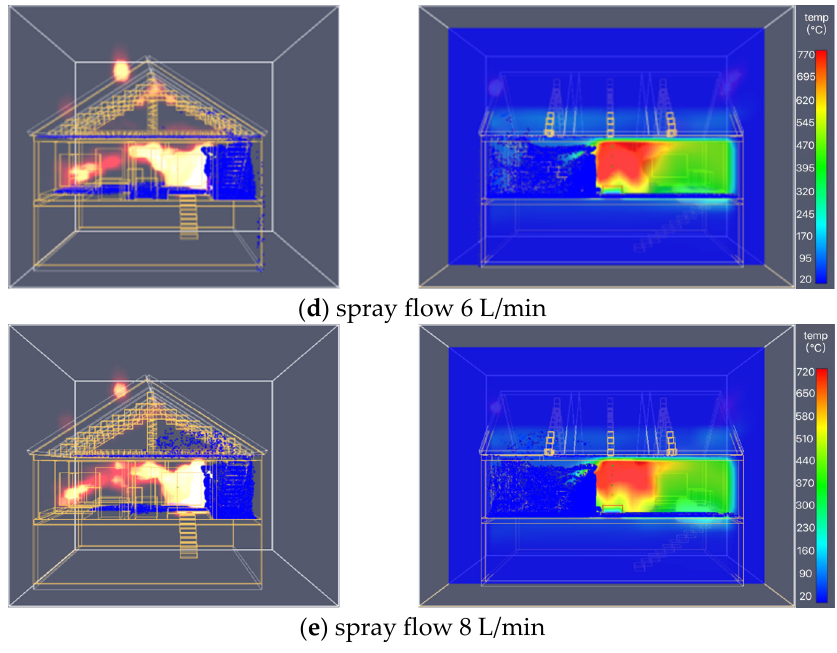
Figure 5. Temperature profiles of different spray flows at 480 s. Table 5. Temperatures at 200, 400, 600, and 800 s at different water-mist flows.